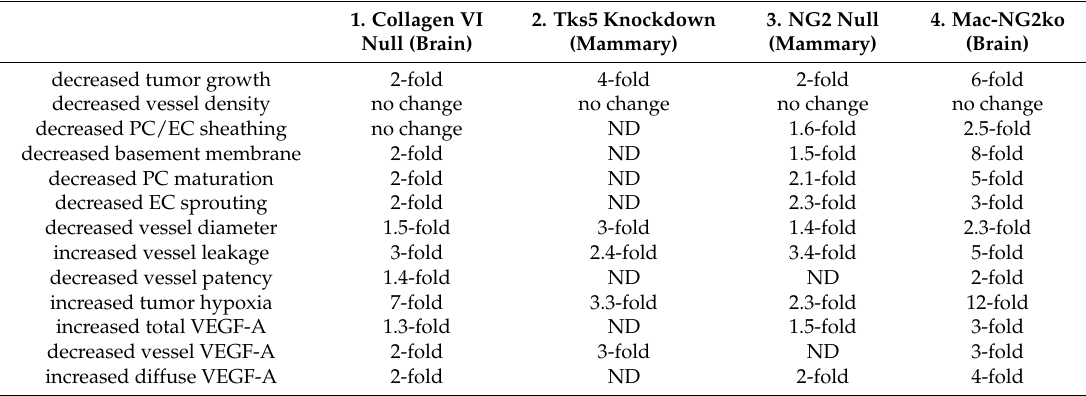
Table 1. Comparisons of tumor vessel structure and